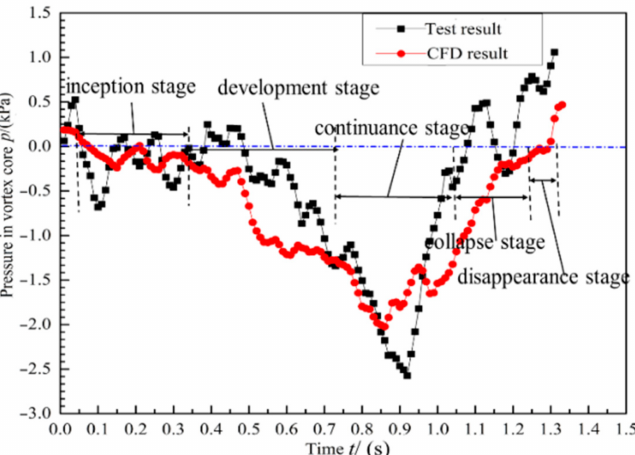
Figure 10. The curve of the pressure over time at the vortex core of the 10 mm section above the bottom of the pump sump.